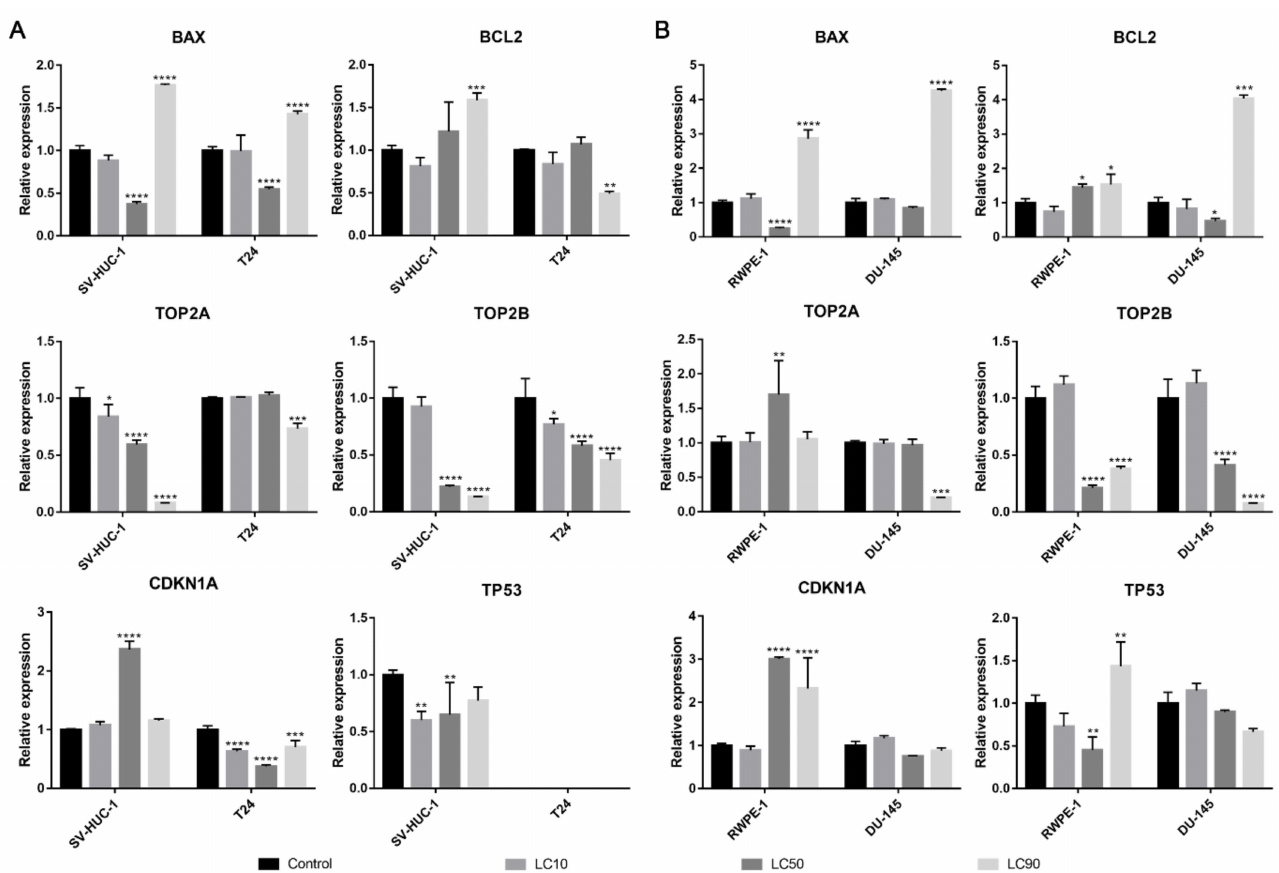
Figure 12. Molecular analysis of gene expression in bladder and prostate cell lines following incubation with levofloxacin. Experiments were performed using LC values of levofloxacin obtained after 24 h incubation. Relative gene expression of control was calculated as 1. ( A )—bladder cell lines. ( B )—prostate cell lines. Statistically significant results compared to control were presented: *— p ≤ 0.05; **— p ≤ 0.01; ***— p ≤ 0.001; ****— p ≤